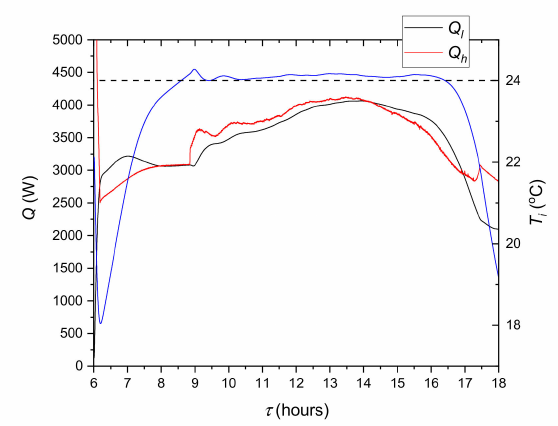
Figure 22. Variation of the temperatures ( a ) and heat transfer rates ( b ) in the modelled office.